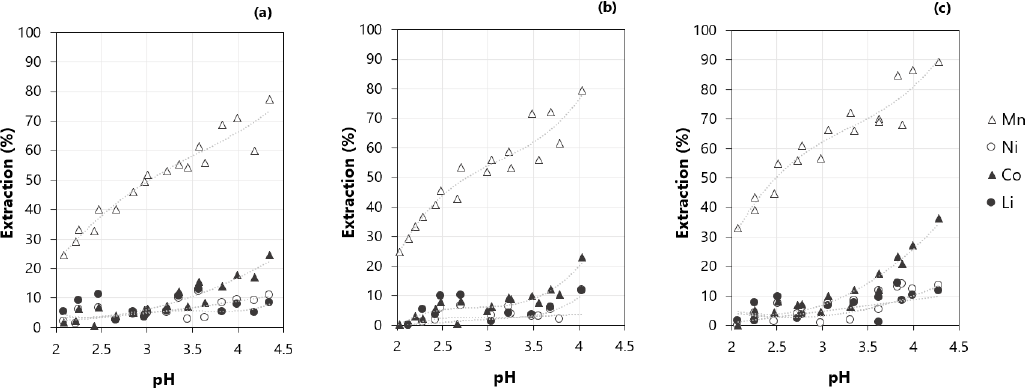
Figure 3. Extraction of metals using different molar concentrations of D2EHPA: ( a ) 0.4 M D2EHPA, ( b ) 0.5 M D2EHPA, ( c ) 0.6 M D2EHPA. Conditions: O:A of 1:1, contact time of 10 min.